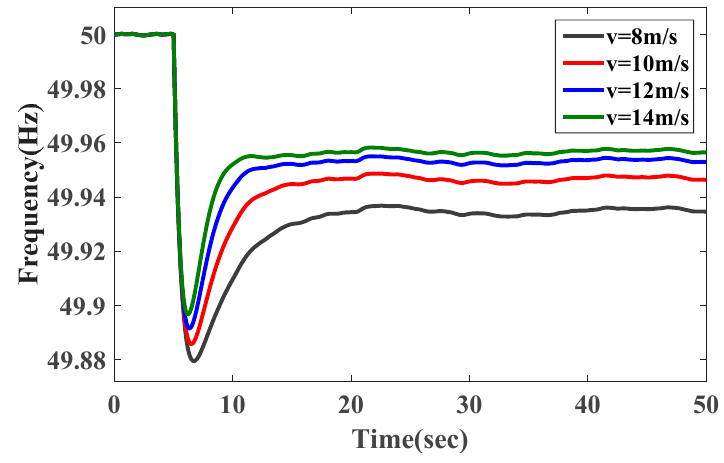
Figure 16. The impact of initial operating wind speed v on frequency dynamic response.